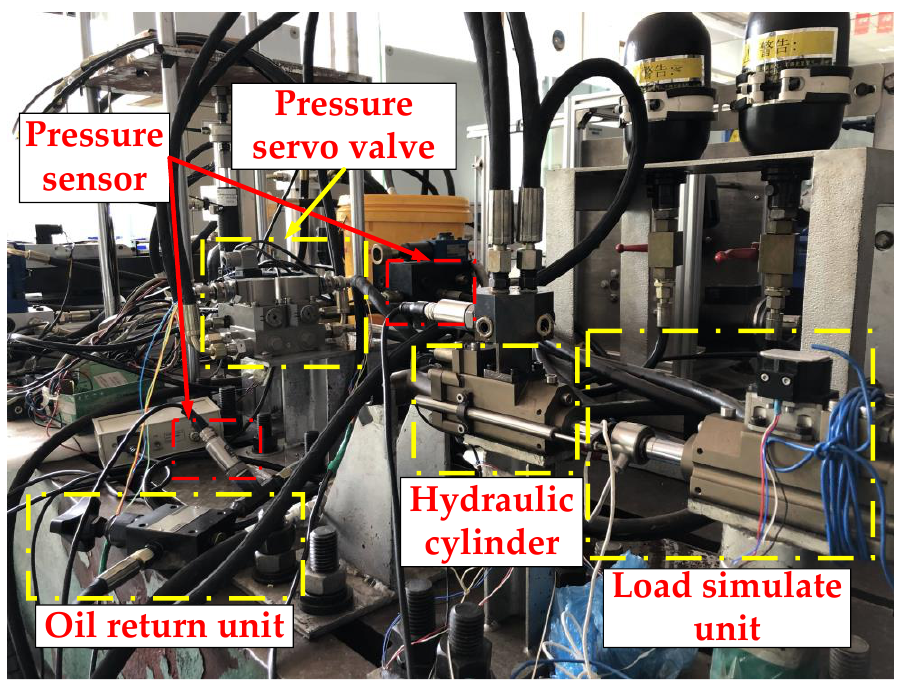
Figure 6. Pressure servo valve experimental platform.